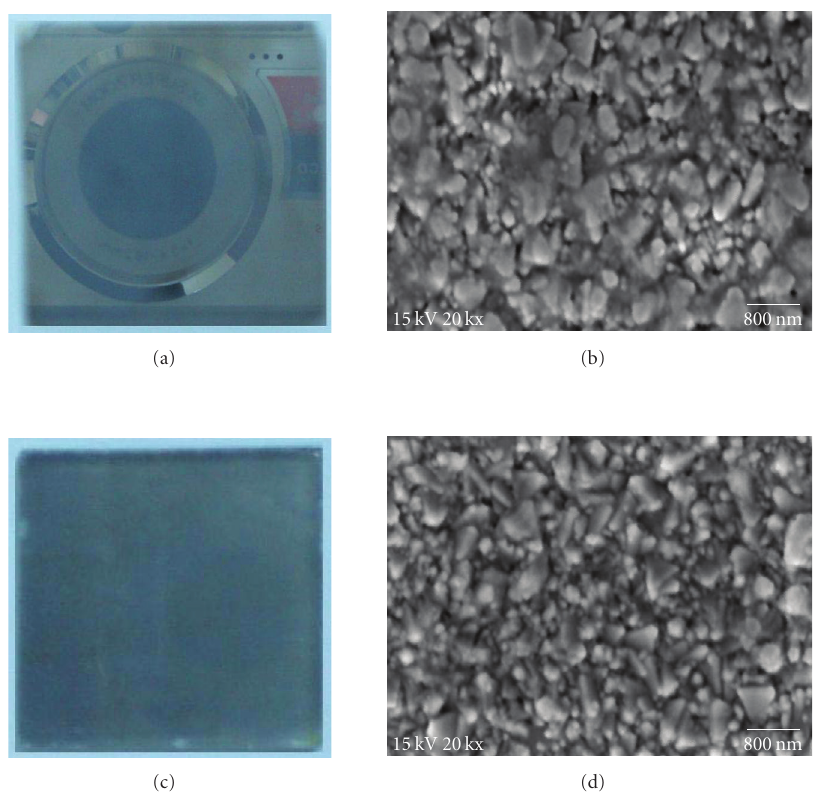
Figure 3: Image of the Pt(E) counter electrode (a), SEM micrograph (20 kx) of the Pt(E) counter electrode (b), image of the Pt(S) counter electrode (c), and SEM micrograph (20kx) of the Pt(S) counter electrode (d).